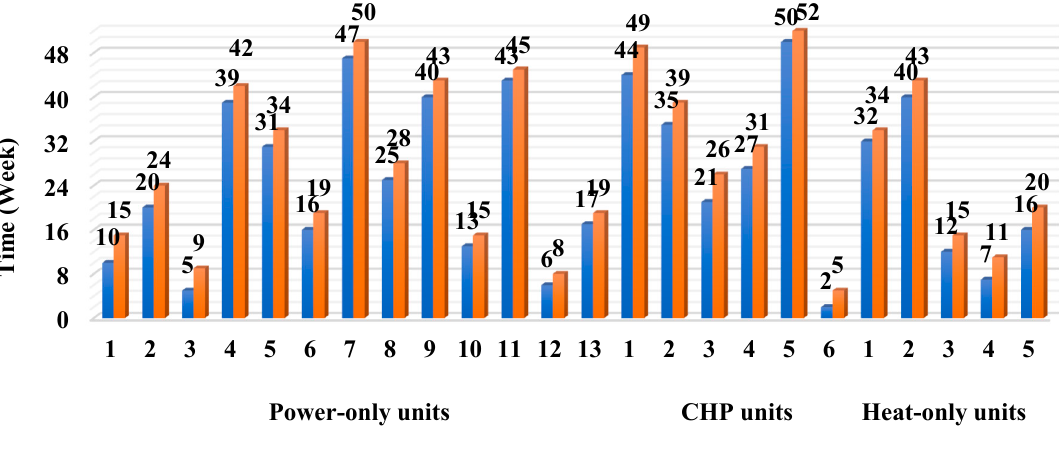
Figure 15. Start and end weeks of maintenance for all units of the second system.